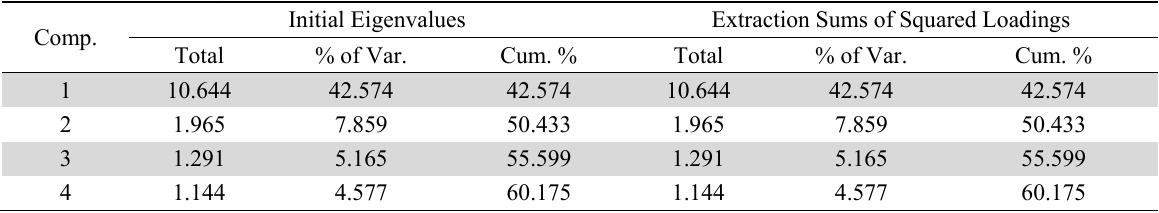
Total Variances Explained